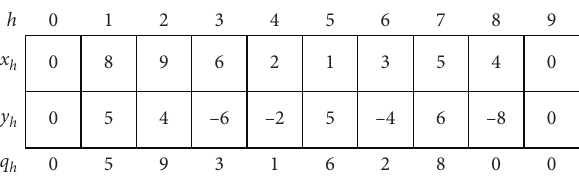
Figure 1: Solution